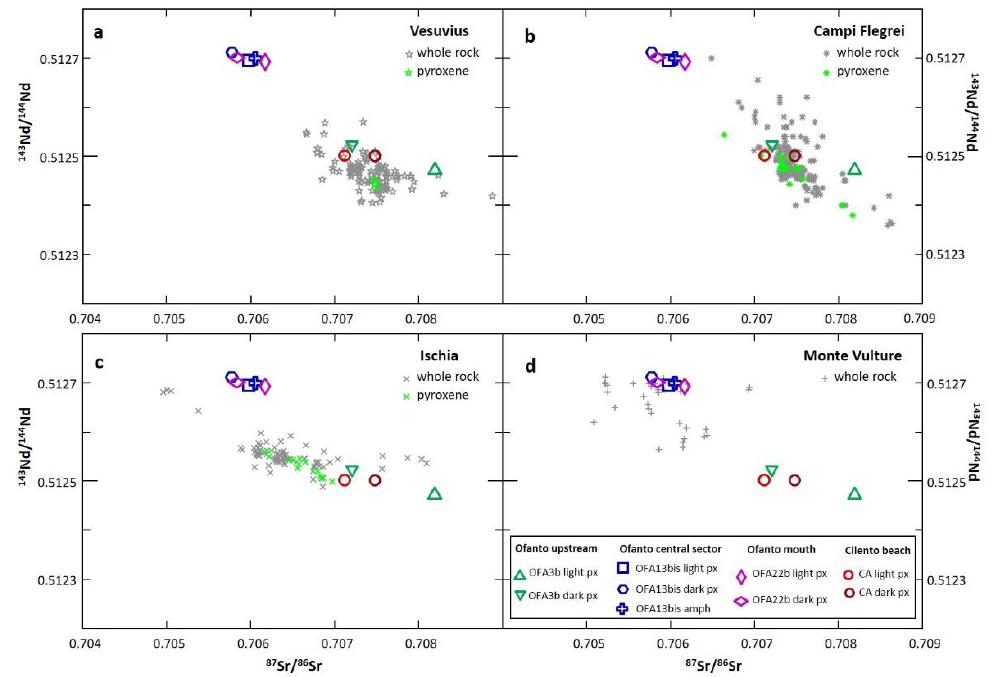
Figure 7. Nd-Sr isotopic composition of the pyroxenes of the studied samples compared to: ( a ) Vesuvius whole-rock and pyroxene (data from [58–64]); ( b ) Campi Flegrei whole-rock and pyroxene (data from [46,53,65–73]); ( c ) Ischia whole-rock and pyroxene (data from [51,61,65,67,74–78]); ( d ) Monte Vulture whole-rock (data from [75,79 – 82])